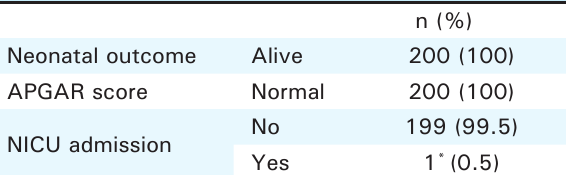
Table 5. Showing newborn characteristics